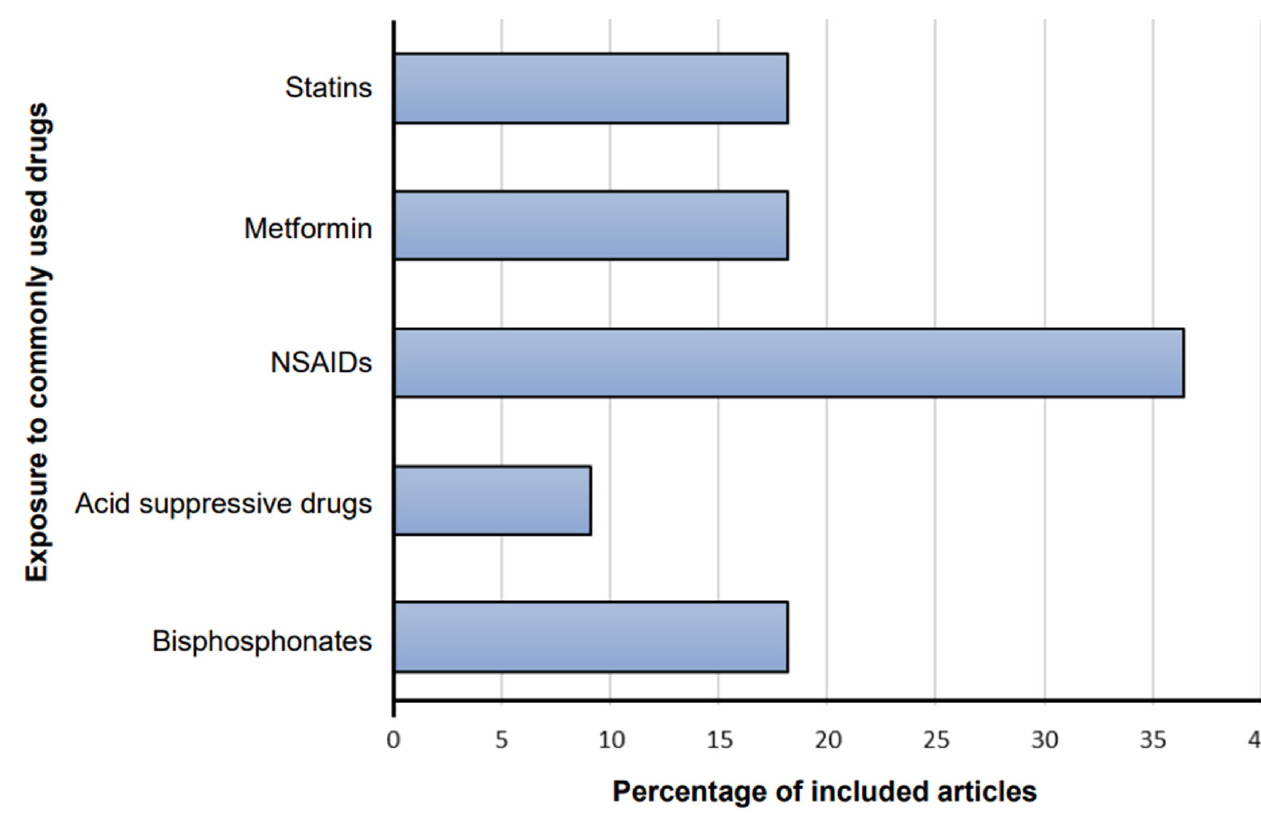
Figure 2. Distribution of included articles related to drug type. Abbreviations: NSAIDs, non-steroidal anti-inflammatory drugs.